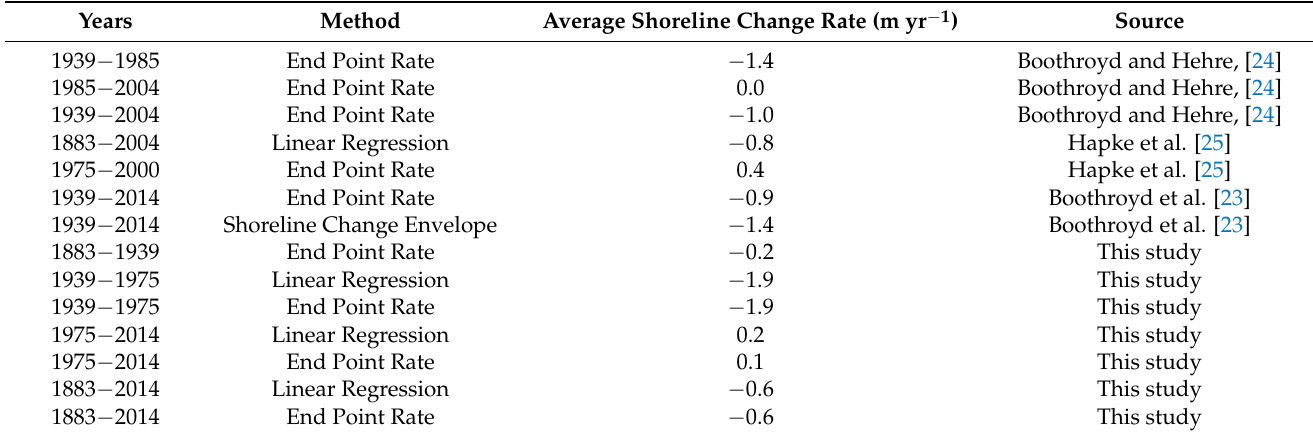
Table 1. Shoreline change rates for the Napatree barrier (transects 20 to 50) from previously published shoreline change maps (Boothroyd and Hehre et al. [24]; Boothroyd et al. [23]; Hapke et al. [25]) and this